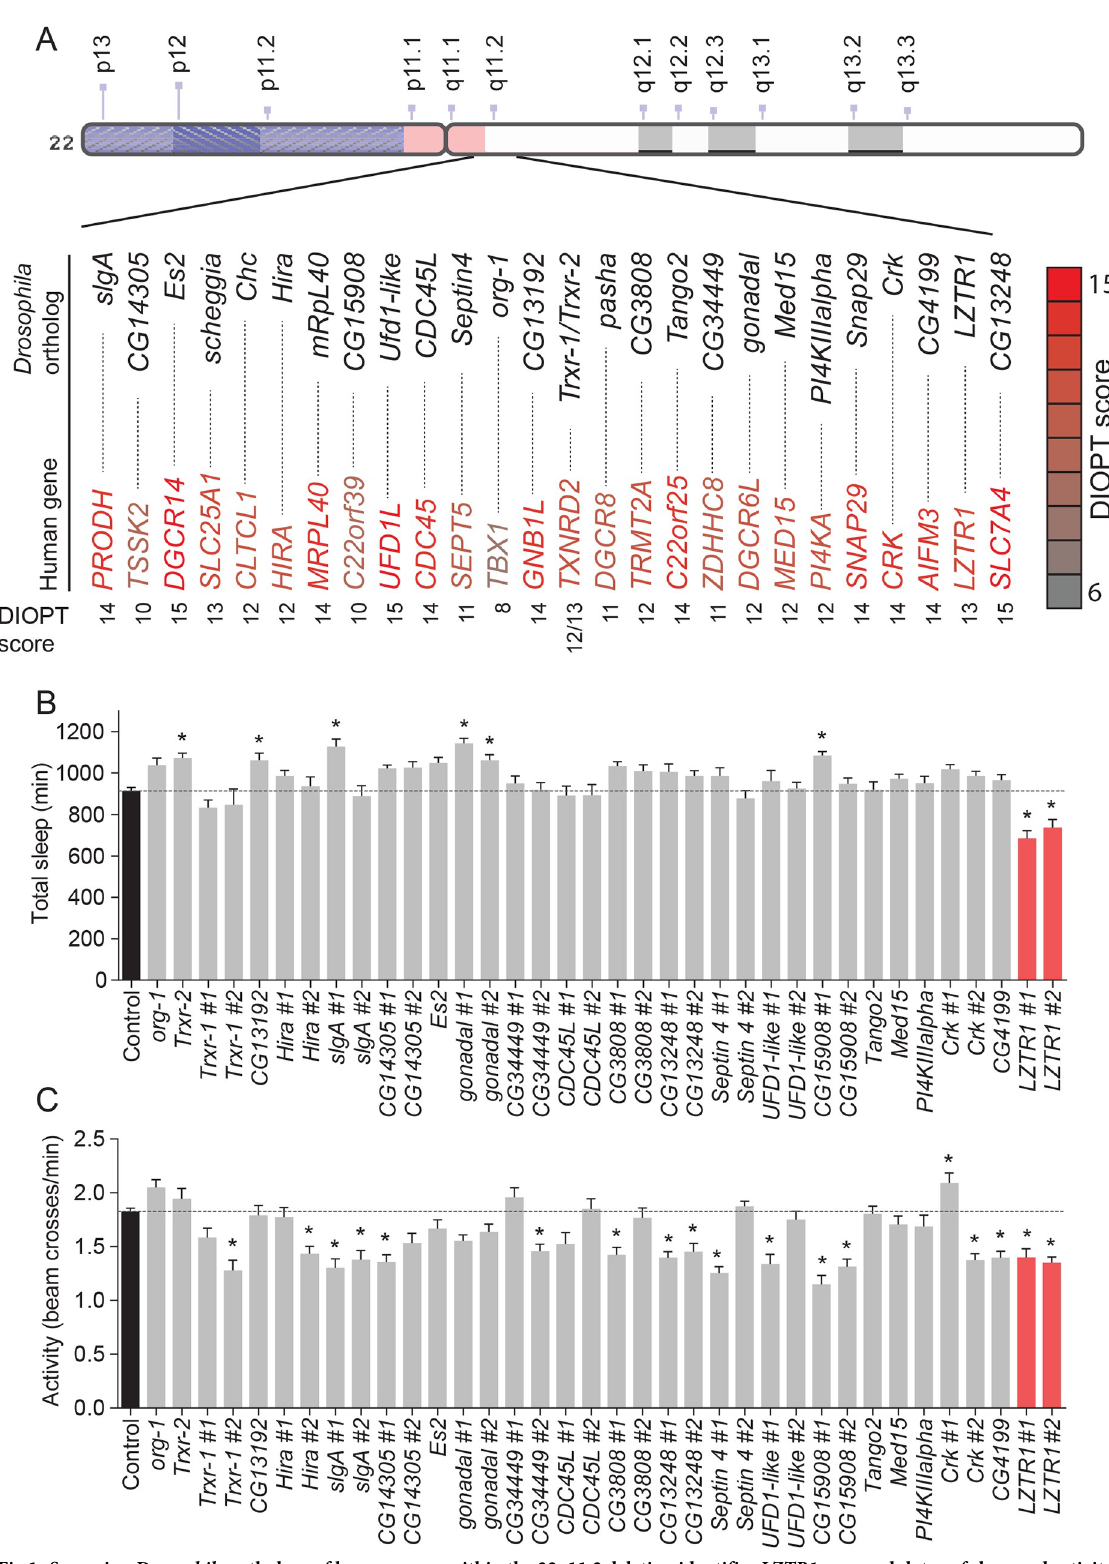
Fig 1. Screening Drosophila orthologs of human genes within the 22q11.2 deletion identifies LZTR1 as a modulator of sleep and activity in Drosophila . (A) Schematic diagram of the human 22q11.2 deletion. For the 43 genes spanned by the 22q11.2 deletion, 26 orthologs